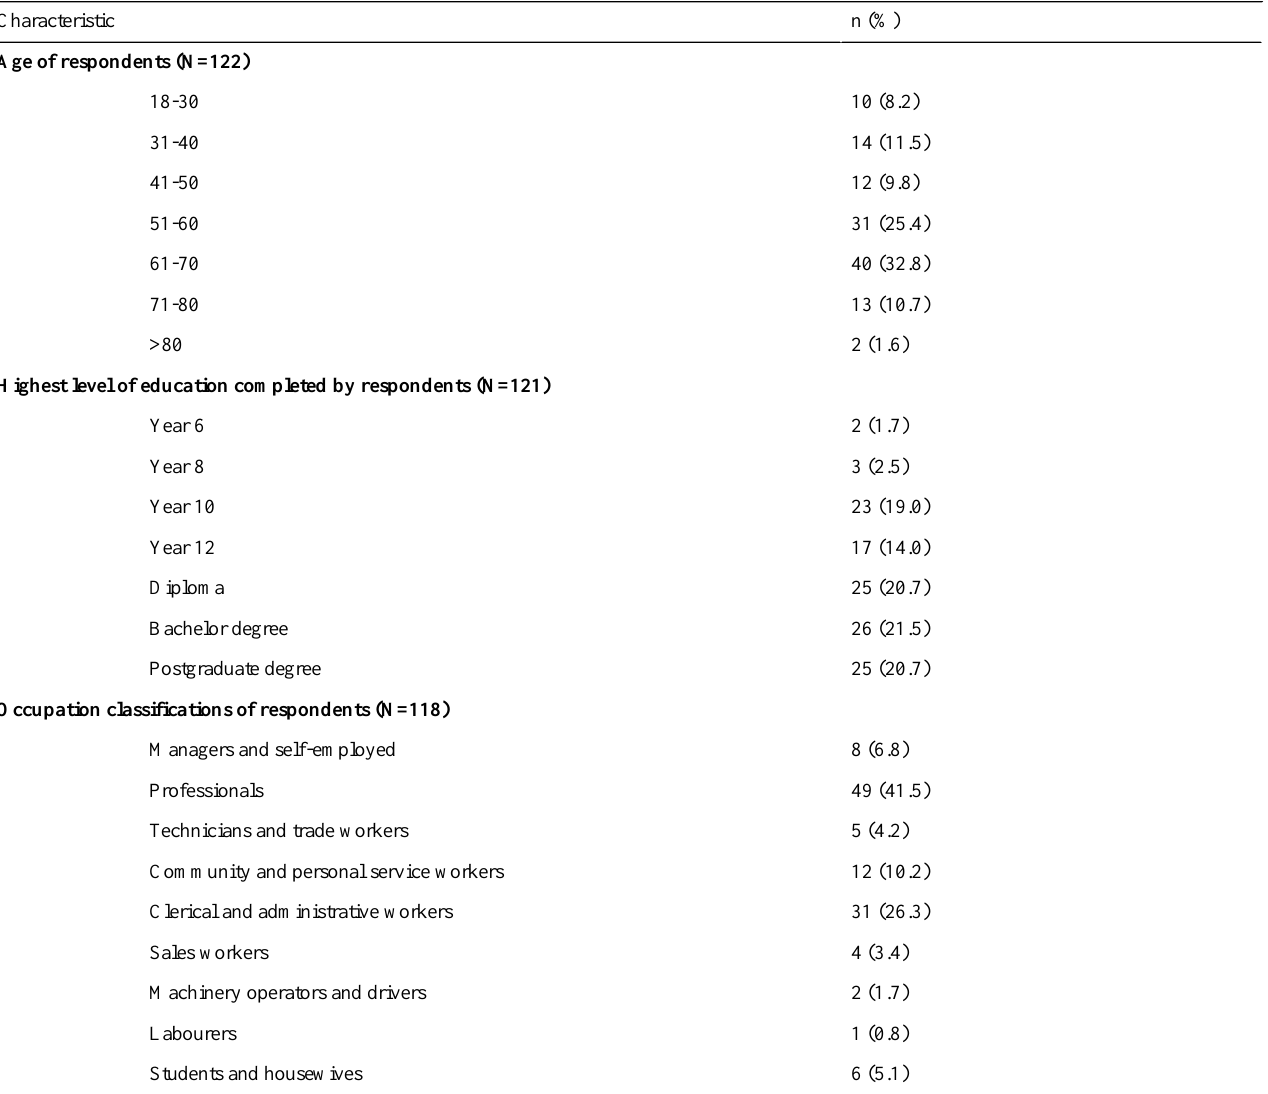
Table 2. Characteristics of respondents.